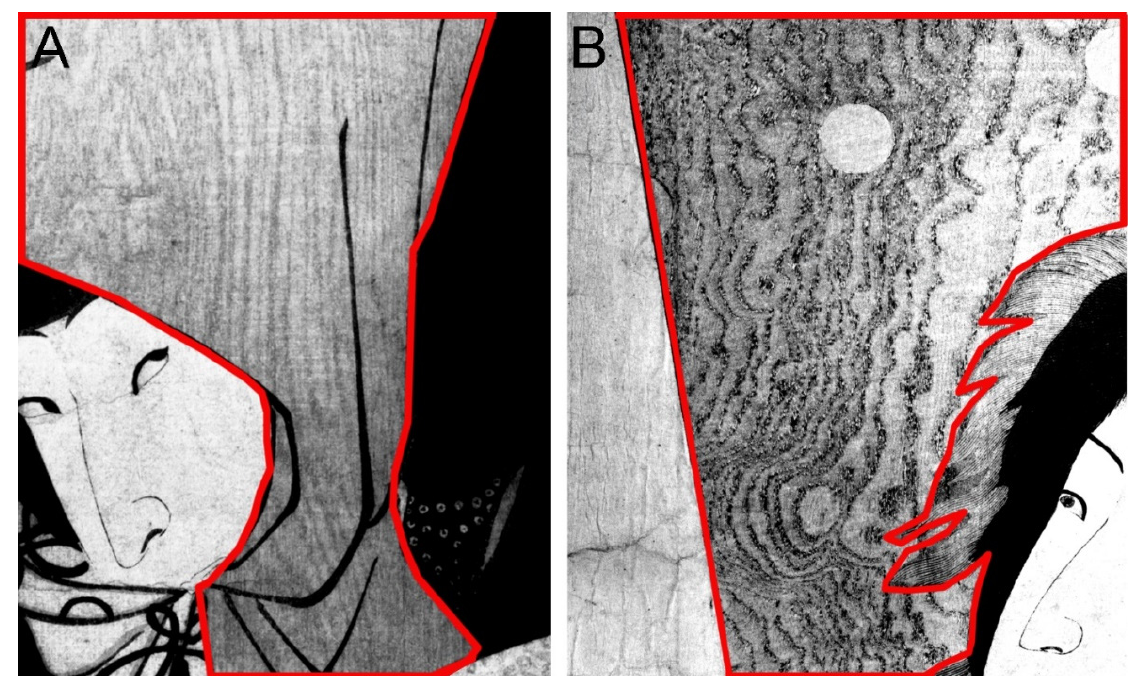
Figure 5. NIR detail of print 4 ( A ) and print 2 ( B ) showing in red outline the enhanced pattern of different woodblocks, typical of the Mokumezuri printing technique.